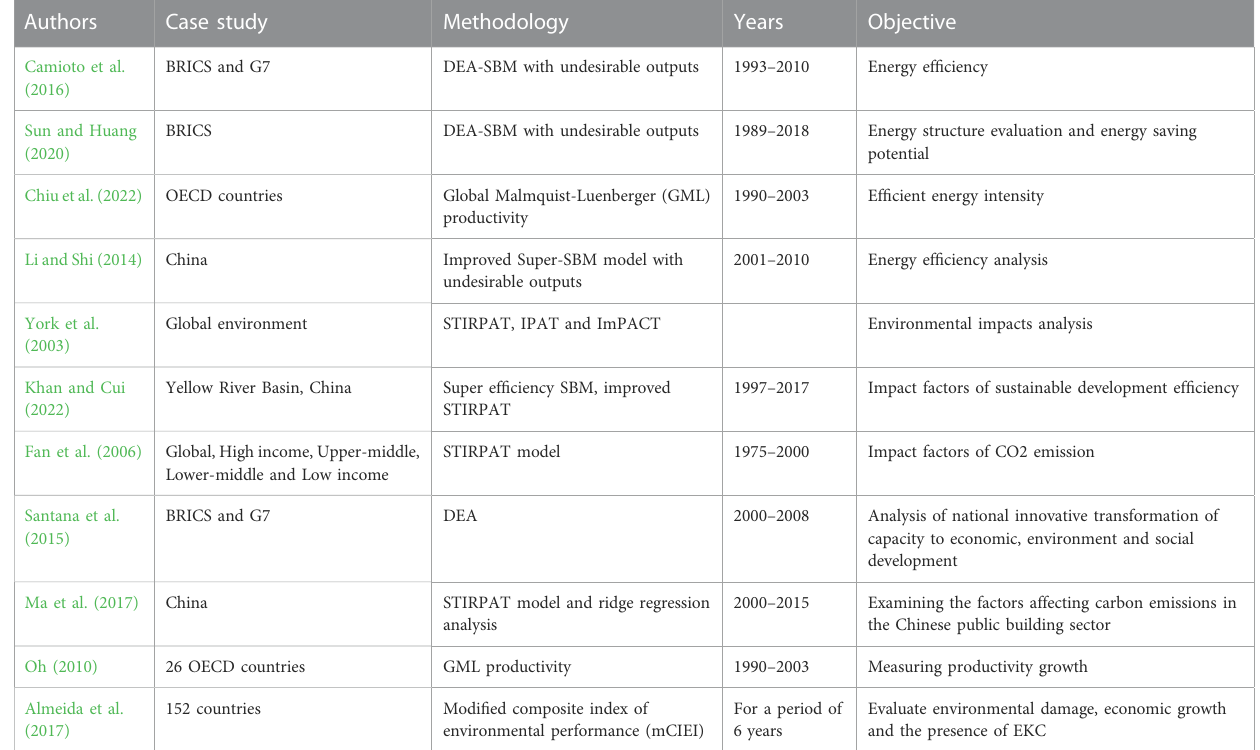
TABLE 1 List of references that analyzed various ef fi